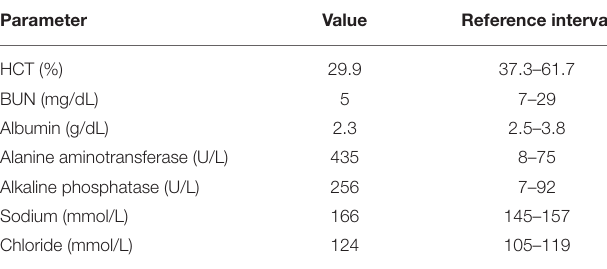
TABLE 2 | CBC and chemistry abnormalities on presentation to the emergency